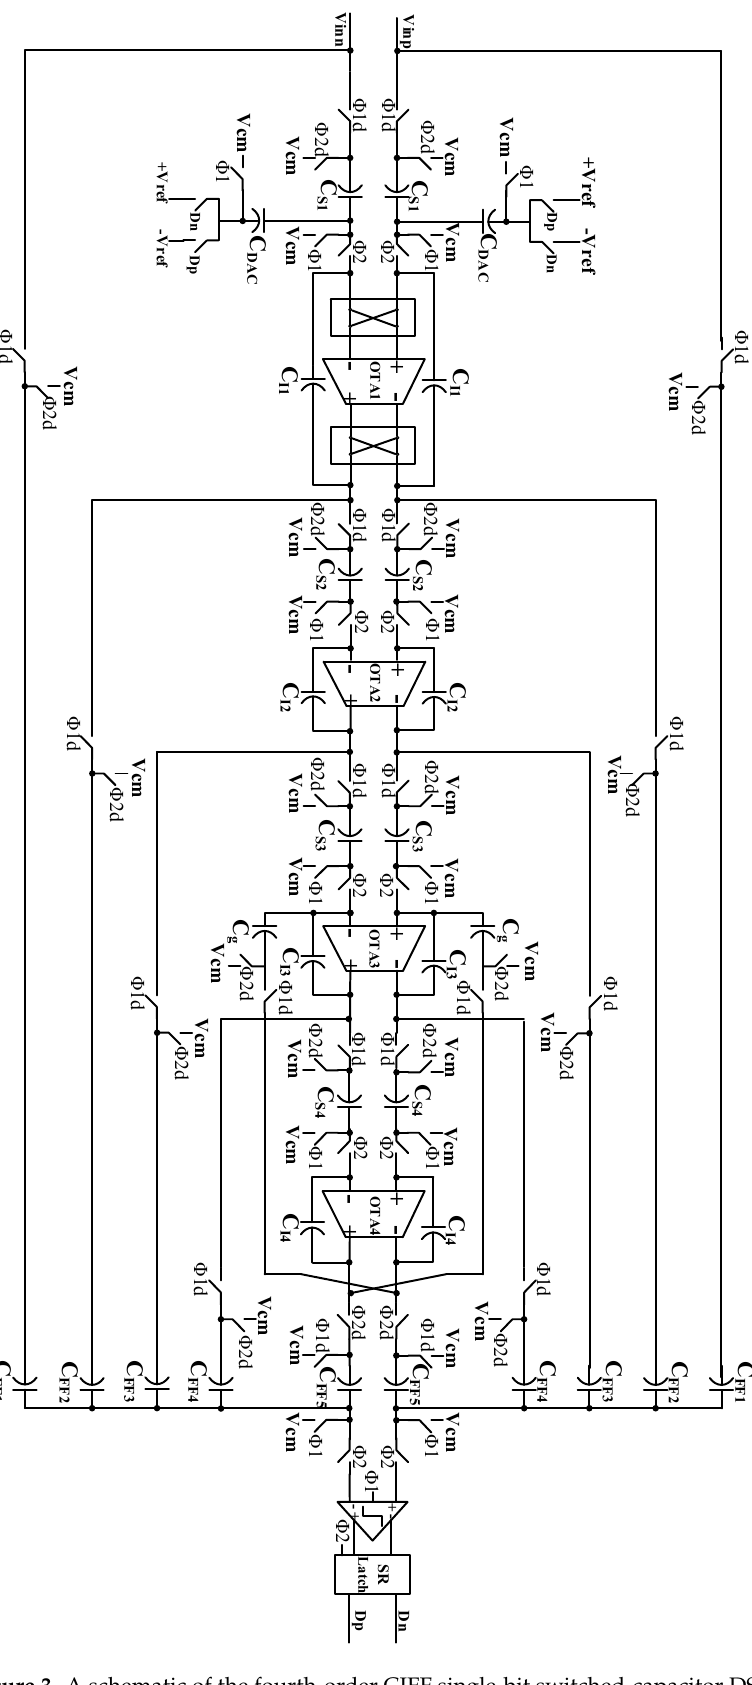
Figure 3. A schematic of the fourth-order CIFF single-bit switched-capacitor DSM. Table 2. Capacitor values used in the DSM (units are in pF).